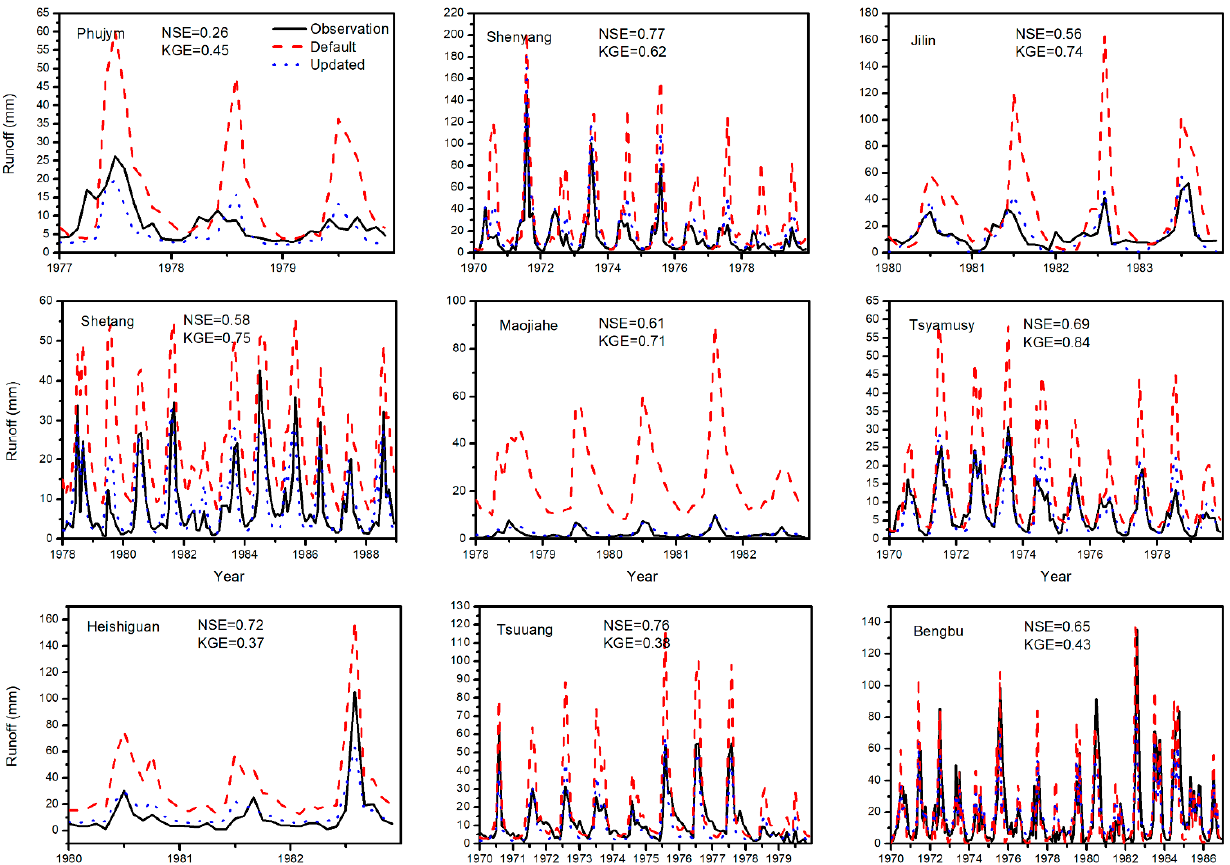
Figure 3. Model evaluations with discharge data from nine representative basins. The stippled lines are observations; dashed lines are simulations based on the default model parameter values, and the solid lines are simulations based on updated soil parameters.